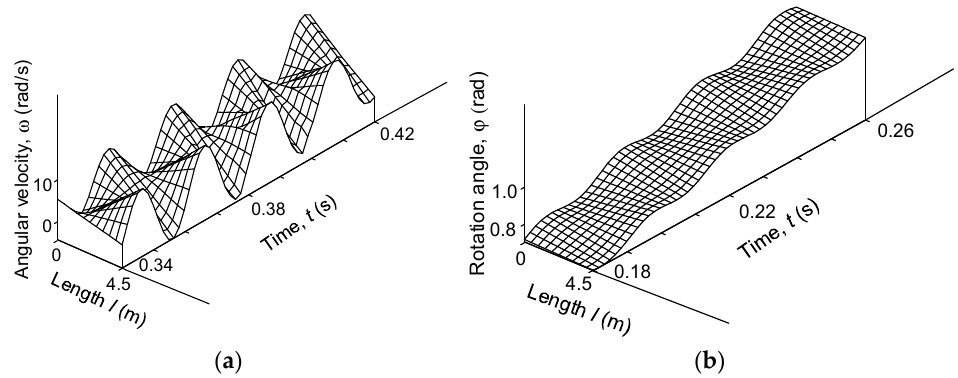
2,3 = π /4 sin(5 t ). The system is in its normal operating condition, i.e., out of resonance.